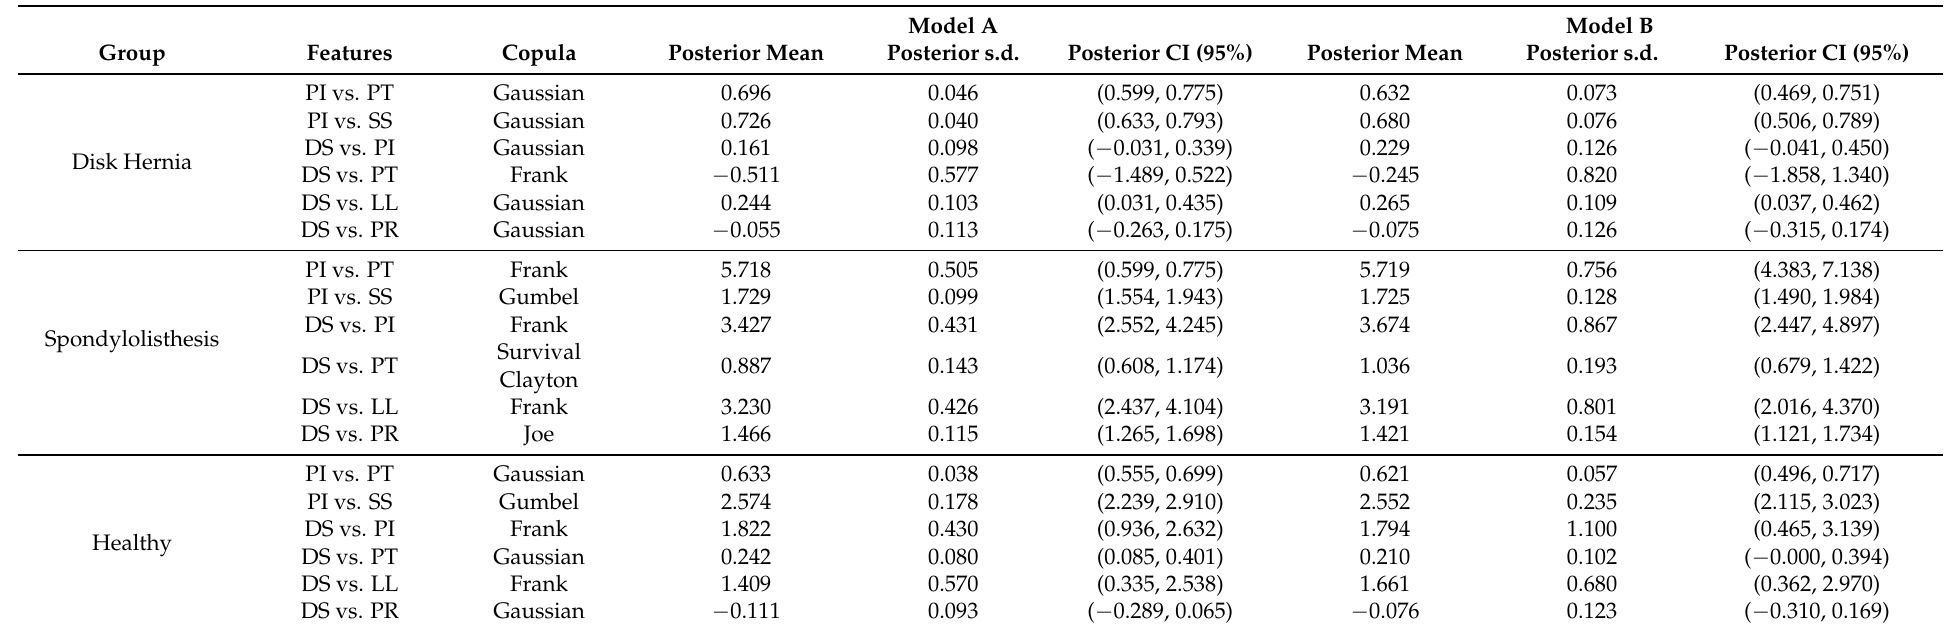
Table 3. Fitted parameters of